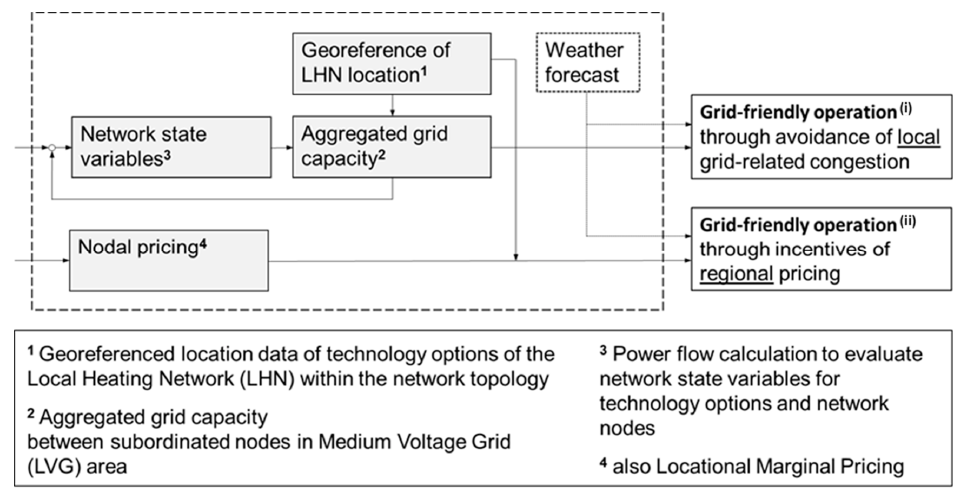
Figure 18. Schematic representation of the modelling approach reflecting a grid-friendly operation of a heating network.